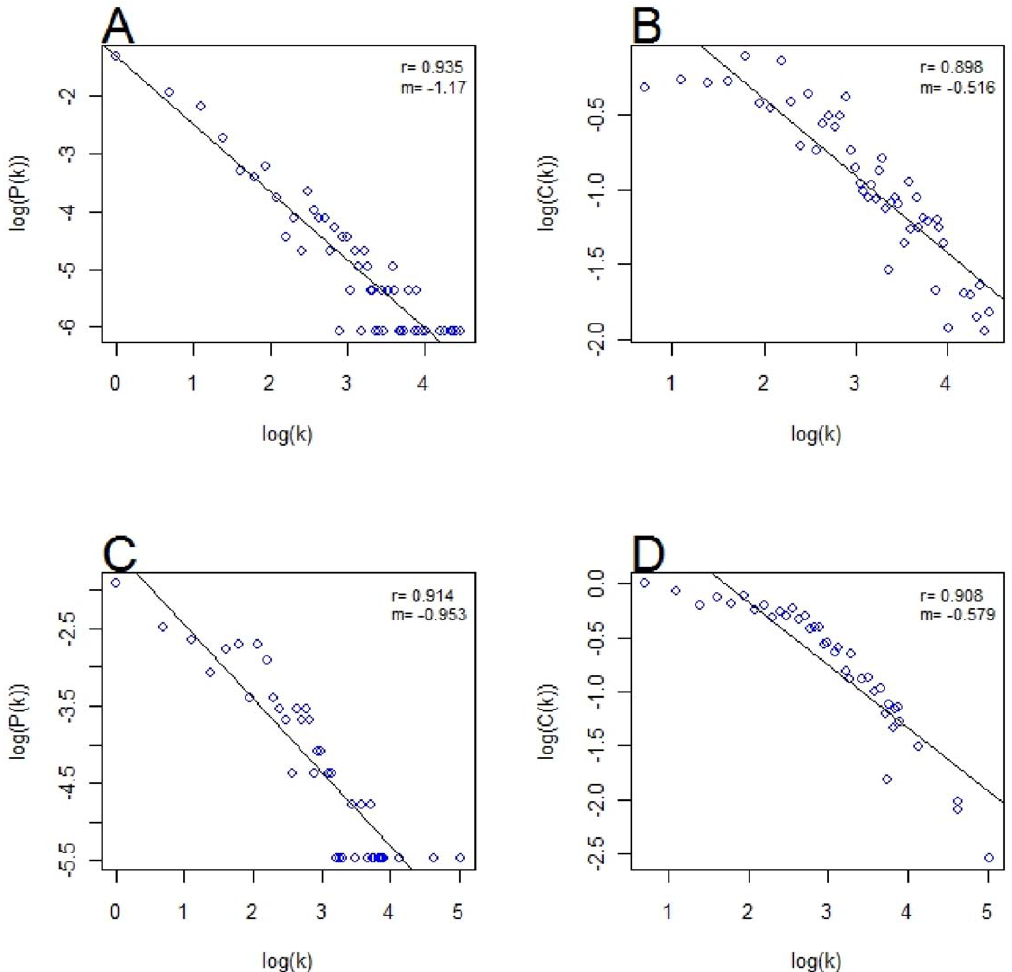
Figure 3. Topological properties of networks gene and phenotype networks at MP level 5. A) Gene network degree distribution and B) clustering coefficient distribution for the gene network at MP level 5, d cutoff =0.009. C) Phenotype Network degree distribution and D) clustering coefficient distribution for the phenotype networks at MP level 5, d cutoff =0.005. Black lines indicate a line of best fit using linear regression.